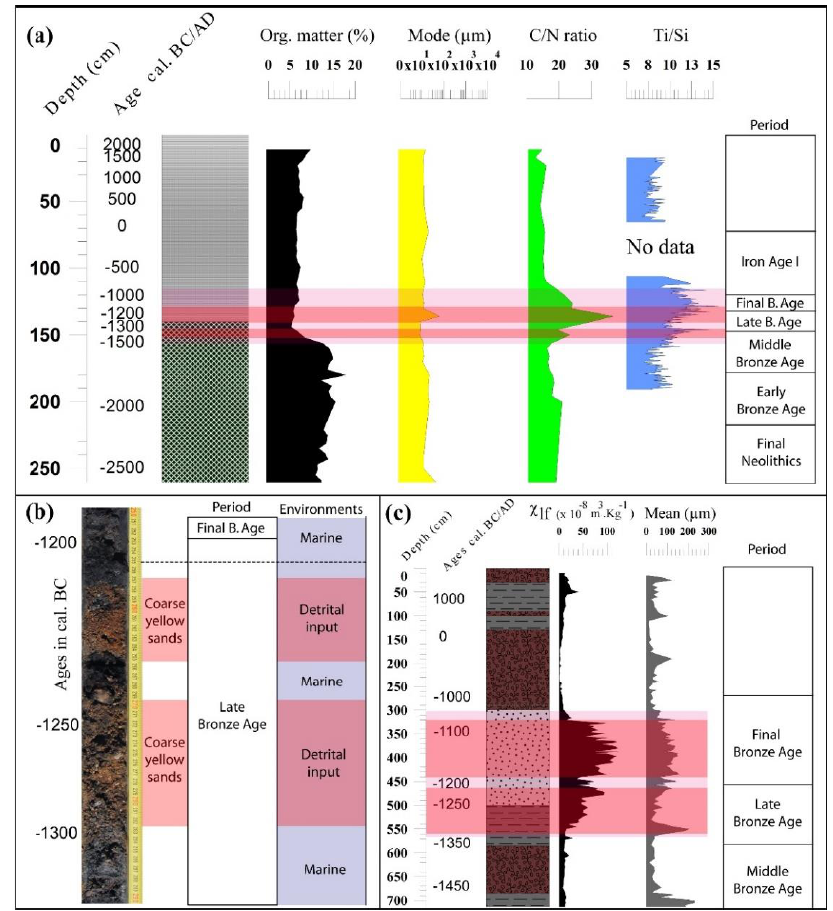
Figure 9. Core chronostratigraphy for Crovani ( a ), Girolata ( b ) and Canniccia ( c ) sites. sedimento- logical (laser granulometry and organic matter content), geochemical (C/N and Ti/Si rates) and magnetic (magnetic susceptibility at low frequency) parameters were included.